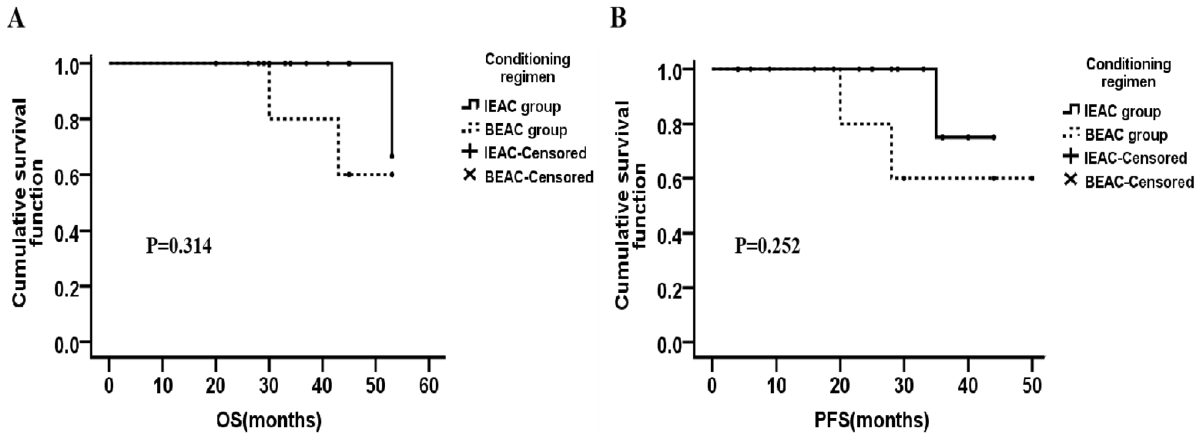
Figure 4. There’s no significant difference in OS and PFS of MCL patients between IEAC group and BEAC